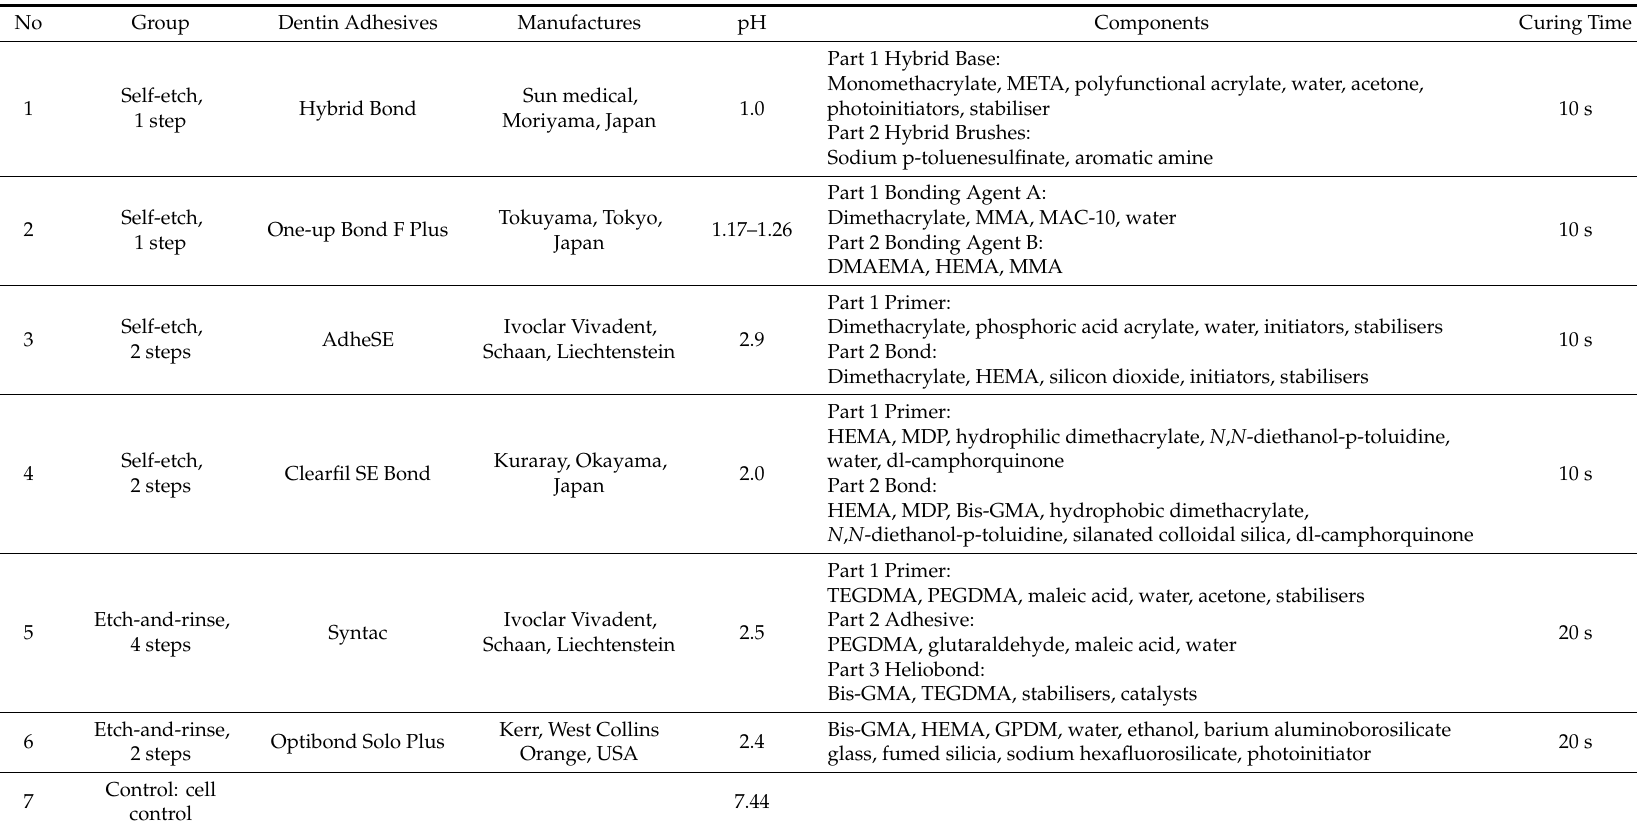
Table 1. Test material and their composition according to